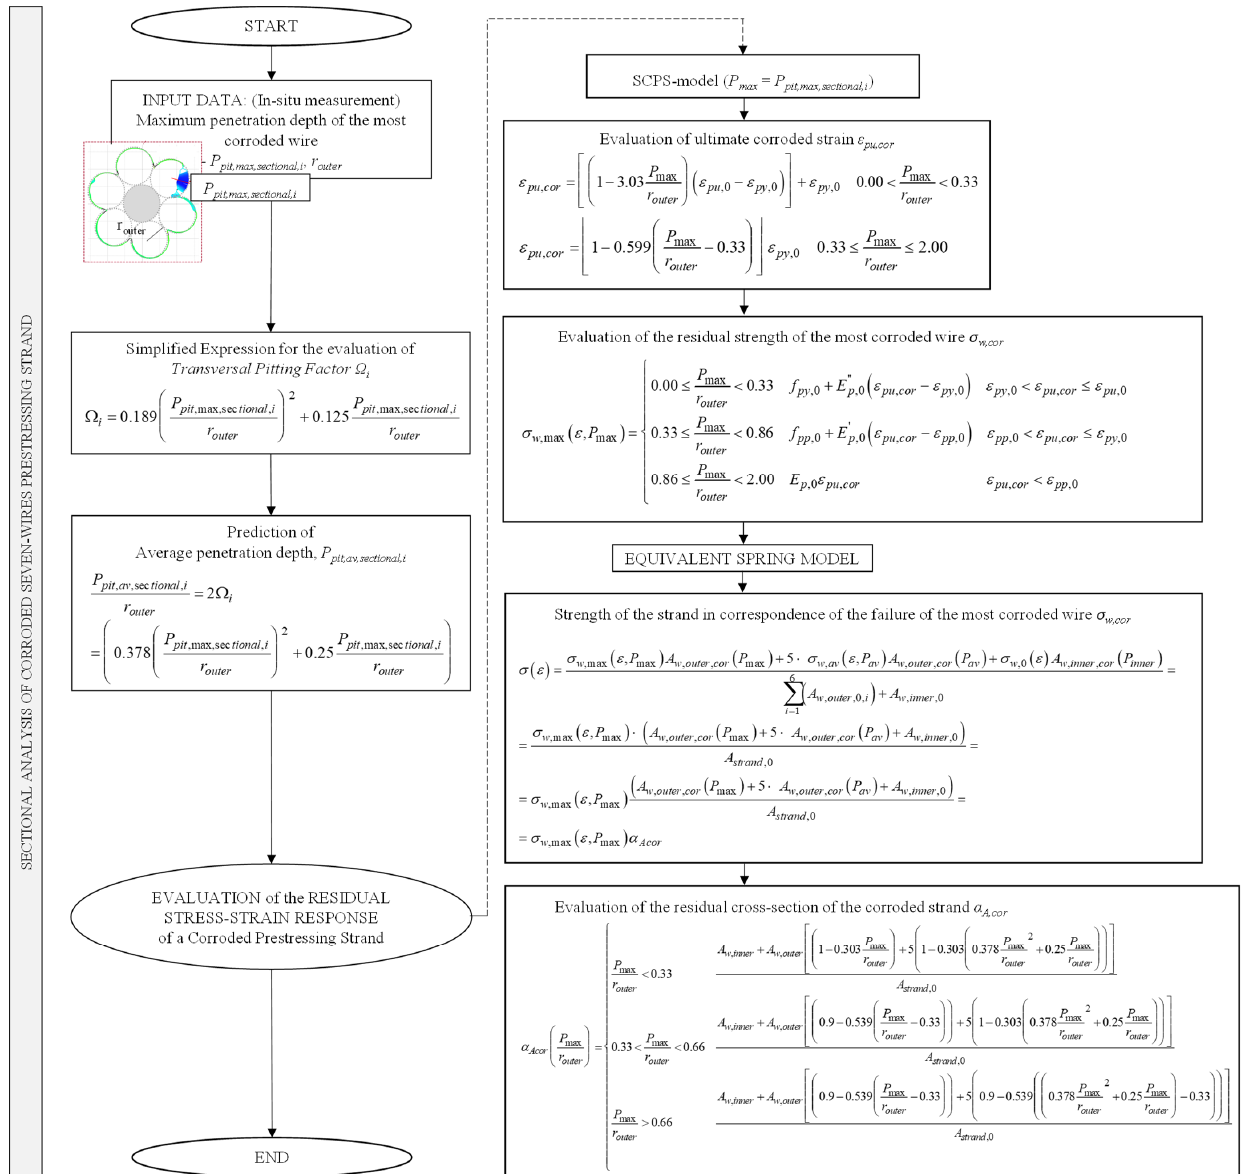
Figure 9. Flowchart of the proposed simplified approach, expressions for the prediction of residual stress-strain response coming from Franceschini et al. [19].